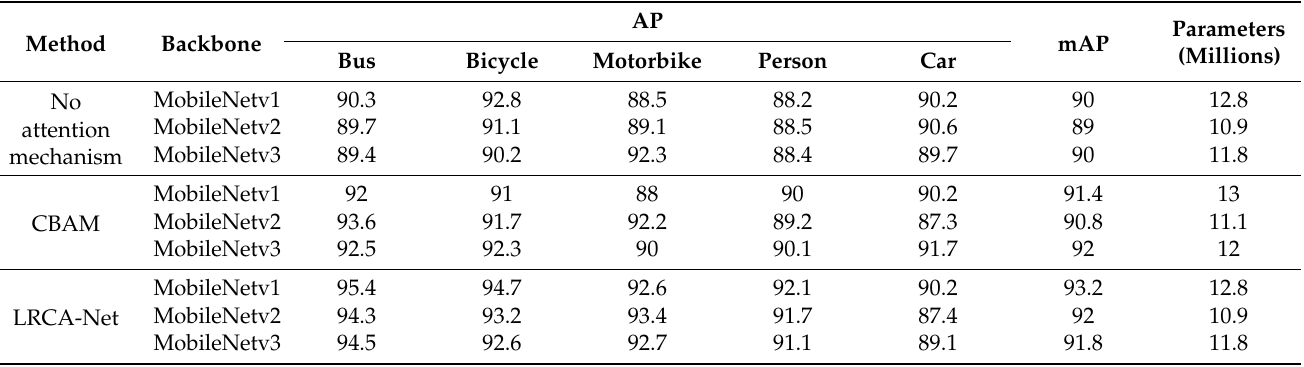
Figure 15. Comparison of attention modules (i.e., no attention module, CBAM, LRCA-Net) in terms of accuracy and network parameters. ( a ) mAP metric for object detection; ( b ) mPA metric for lane detection. Table 4. Comparison of no attention module, CBAM module, and LRCA-Net in the object detection model.